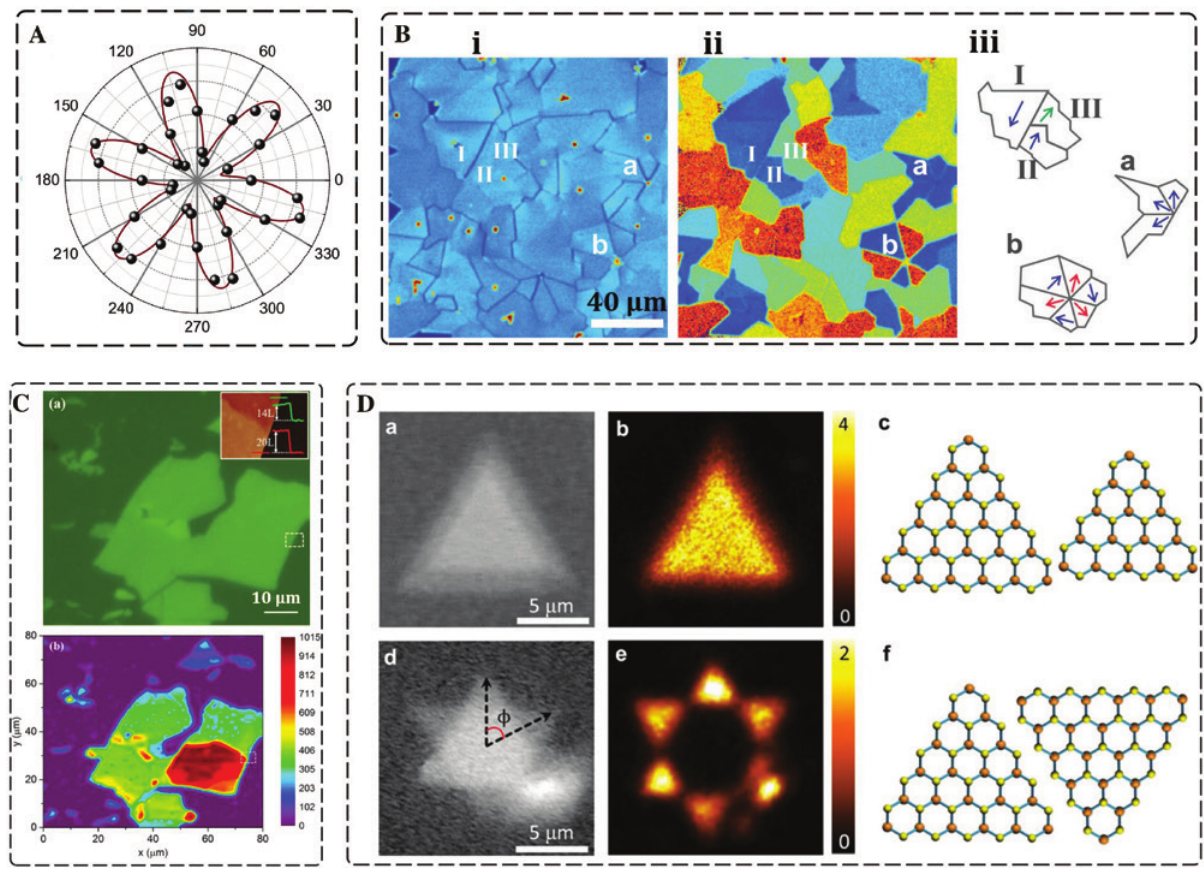
Figure 14: All optical characterization and imaging of 2DLMs. (A) Polar plot of SHG emission from monolayer MoS 2013 American Physical Society. (B) (i) SHG image of a polycrystalline large area CVD-grown monolayer of MoS